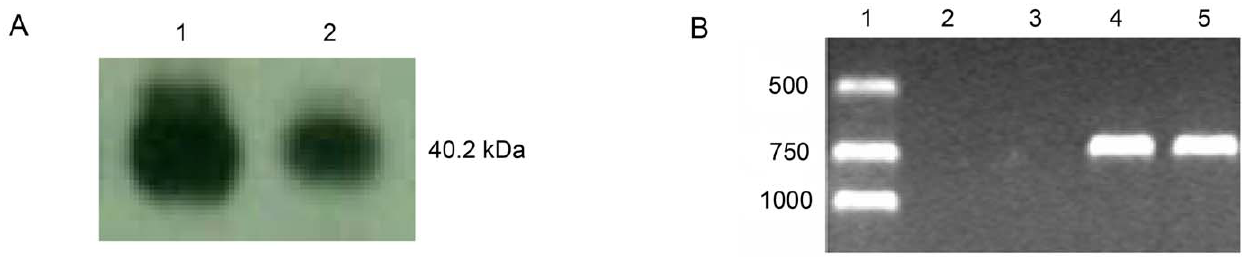
Figure 6. Zebrafish TS protein interacted with its own mRNA in vivo. A , Western blot analysis was performed with purified recombinant zebrafish TS (lane 1) or protein from the immunoprecipitation complex (lane 2) and detected with human TS106 antibody. B , RT-PCR products using the RNA extracted from immunoprecipitation complex as the template. TS mRNA from nt 340–1040 was amplified by RT-PCR using TS-specific primers (lanes 4 and 5). RNA and protein complex was precipitated without TS antibody and RT-PCR was performed (lane 2). Lane 3 indicates the RT- PCR results precipitating the complex with unrelated polyclonal antibody, CHX10-like zebrafish antibody (GenWay Biotech, CA). Lane 1 represents the DNA marker of molecular weight.